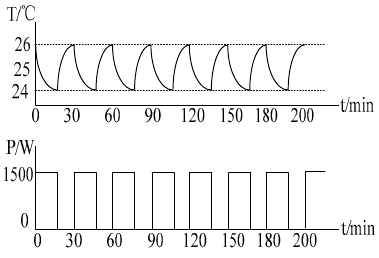
Figure 3. Power demand and temperature changes during air-conditioning